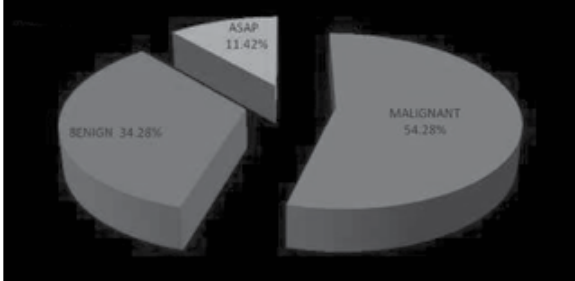
6 (3 + Figure 6 – Final diagnosis by IHC of cases diagnosed as ASAP in the initial series ( n = 35) IHC: immunohistochemistry; ASAP: atypical small acinar proliferation.